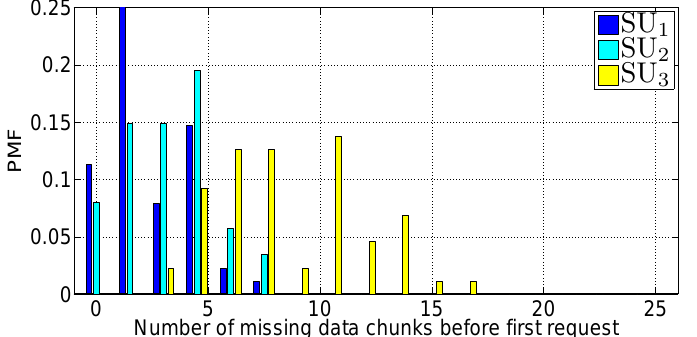
Figure 12. PMF of missing DATA chunks, before the first REQUEST round in Scenario